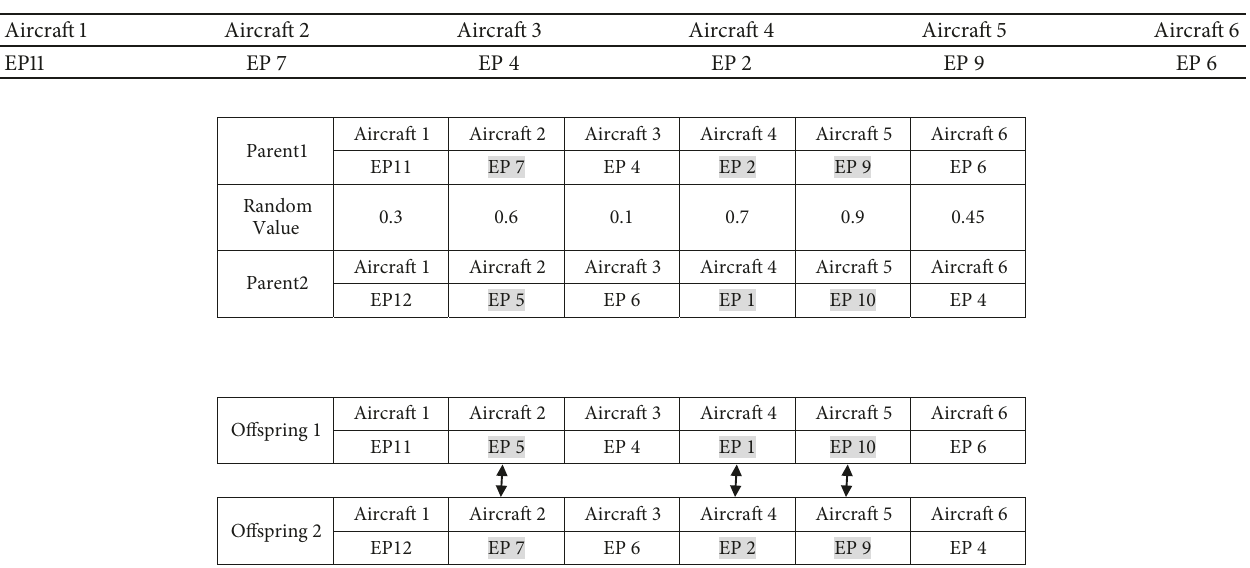
Table 2: Chromosomes structure.